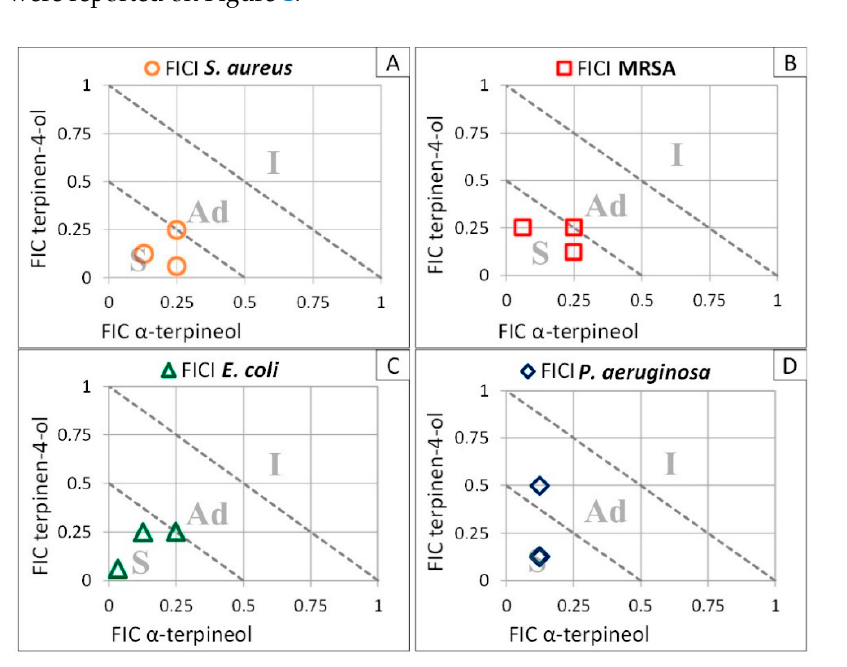
Figure 1. Synergy between α -terpineol and terpinen-4-ol. Synergy assays between the two terpenic alcohols, α -terpineol and terpinen-4-ol, were performed on: ( A ) Staphylococcus aureus ○ , ( B ). methicillin-resistant Staphylococcus aureus □ , ( C ) Escherichia coli ∆ , and ( D ) Pseudomonas aeruginosa ◊ . The